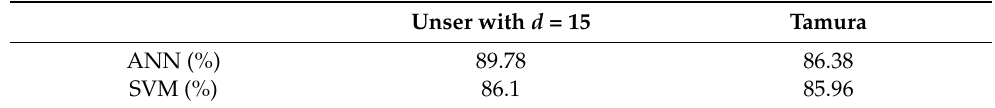
Table 3. Accuracy percentage mean ( µ ) for the ANN and SVM classifiers by considering different contrast estimation methods.